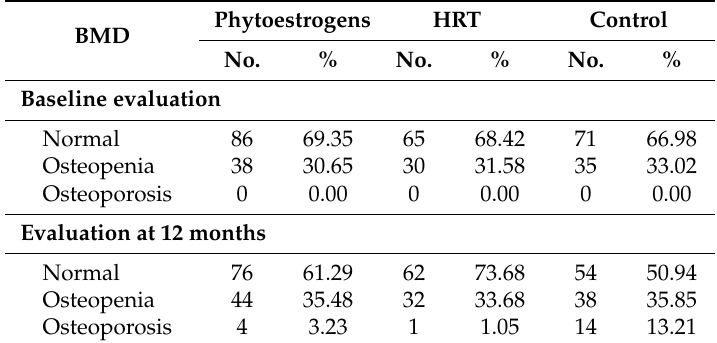
Table 4. Evolution of cases according to T-score.